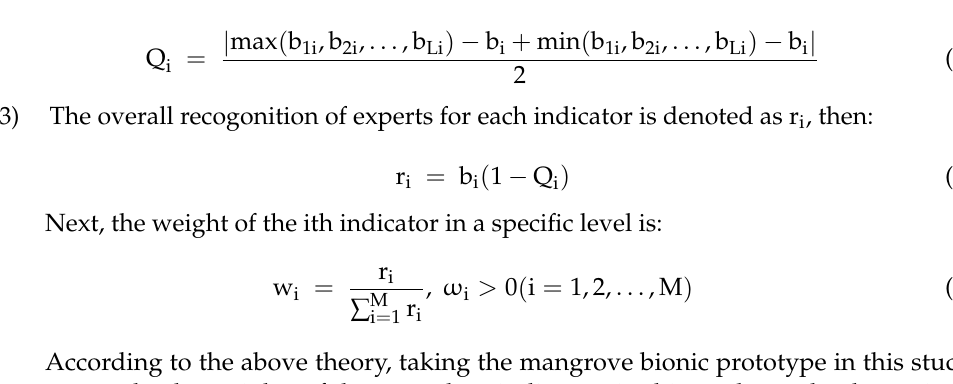
Table 2. The weight of secondary indicators. Second Level Indicators Weight U11: Developed root system 0.8 U12: Monodominant Community